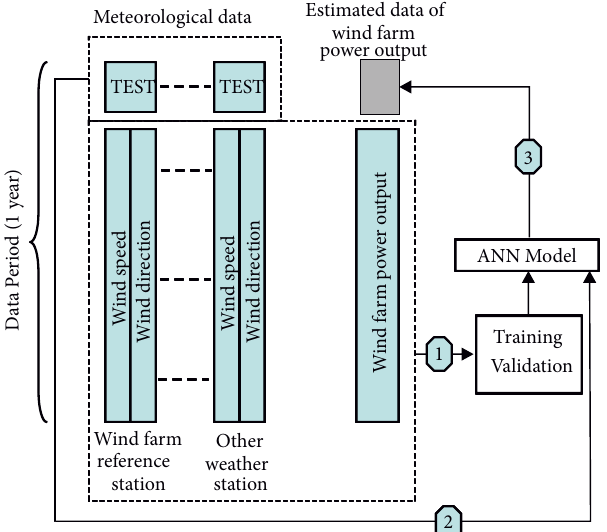
Figure 5: General layout of the methodology followed to obtain the adaptive wind farm power curves.